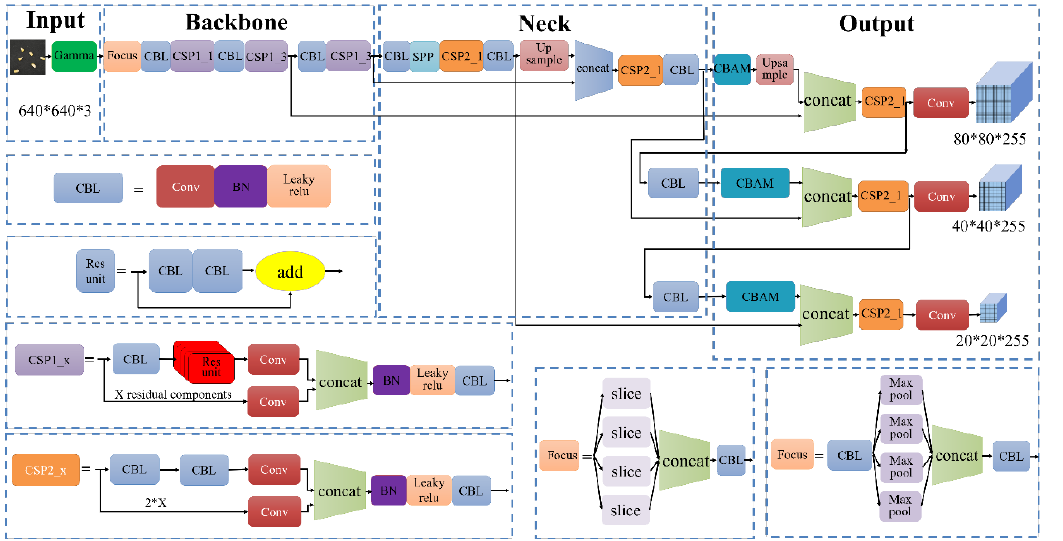
Figure 6. Architecture of YOLOv5s network.